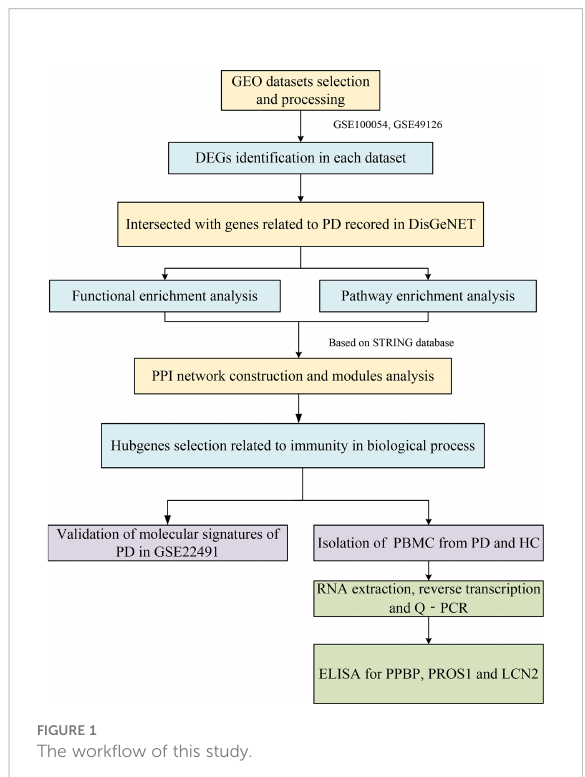
FIGURE 1 The work fl ow of this